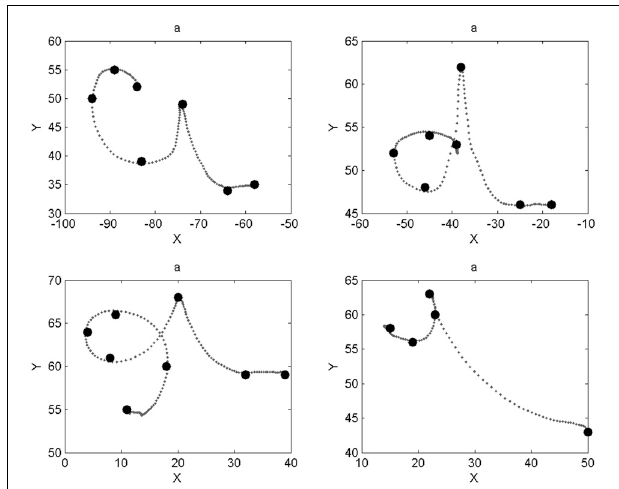
FIGURE 10 | Different letters “a” present in the database. The two trajectories in the top row are correctly identified as letter “a” (the writer performs letter “d” differently than in the top right panel). The example in the bottom left panel is incorrectly recognized as a “b” (very similar shape except for a longer downward stroke during the first loop); the example in the bottom right panel is incorrectly recognized as a “t” (most “t” exemplars do not have a bar).